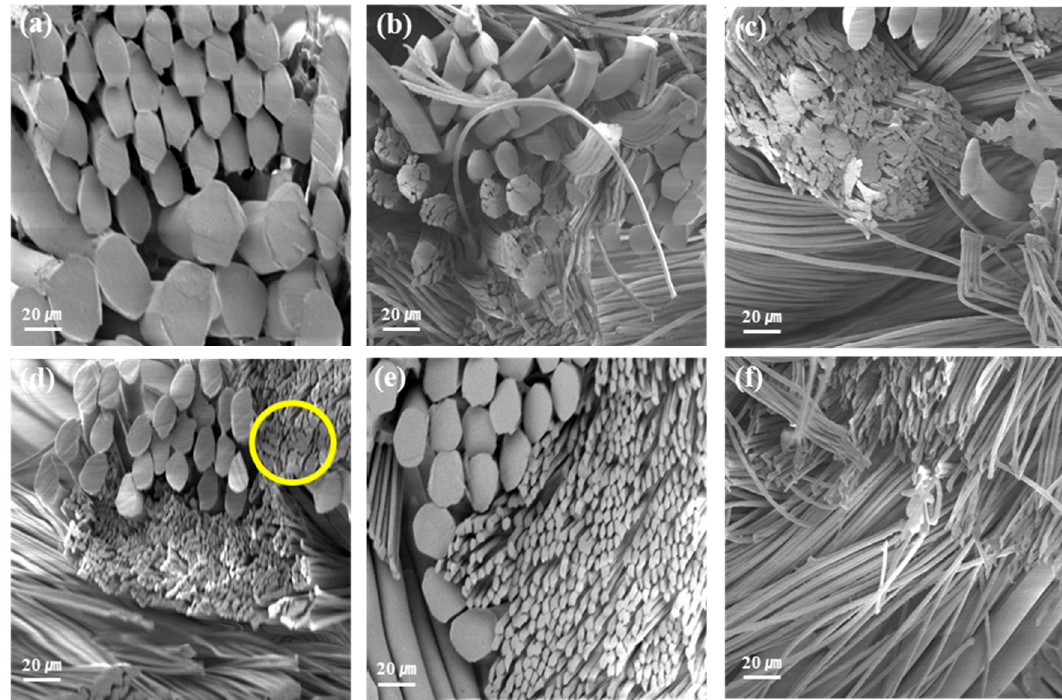
Figure 3. SEM images of sea-island ultramicrofibers of PET tricot fabrics before and after alkali treatment with various NaOH concentrations at 100 °C for 30 min: ( a ) untreated, ( b ) 10% omf NaOH, ( c ) 15% omf NaOH, ( d ) 20% omf NaOH, ( e ) 25% omf NaOH, and ( f ) 30% omf NaOH.